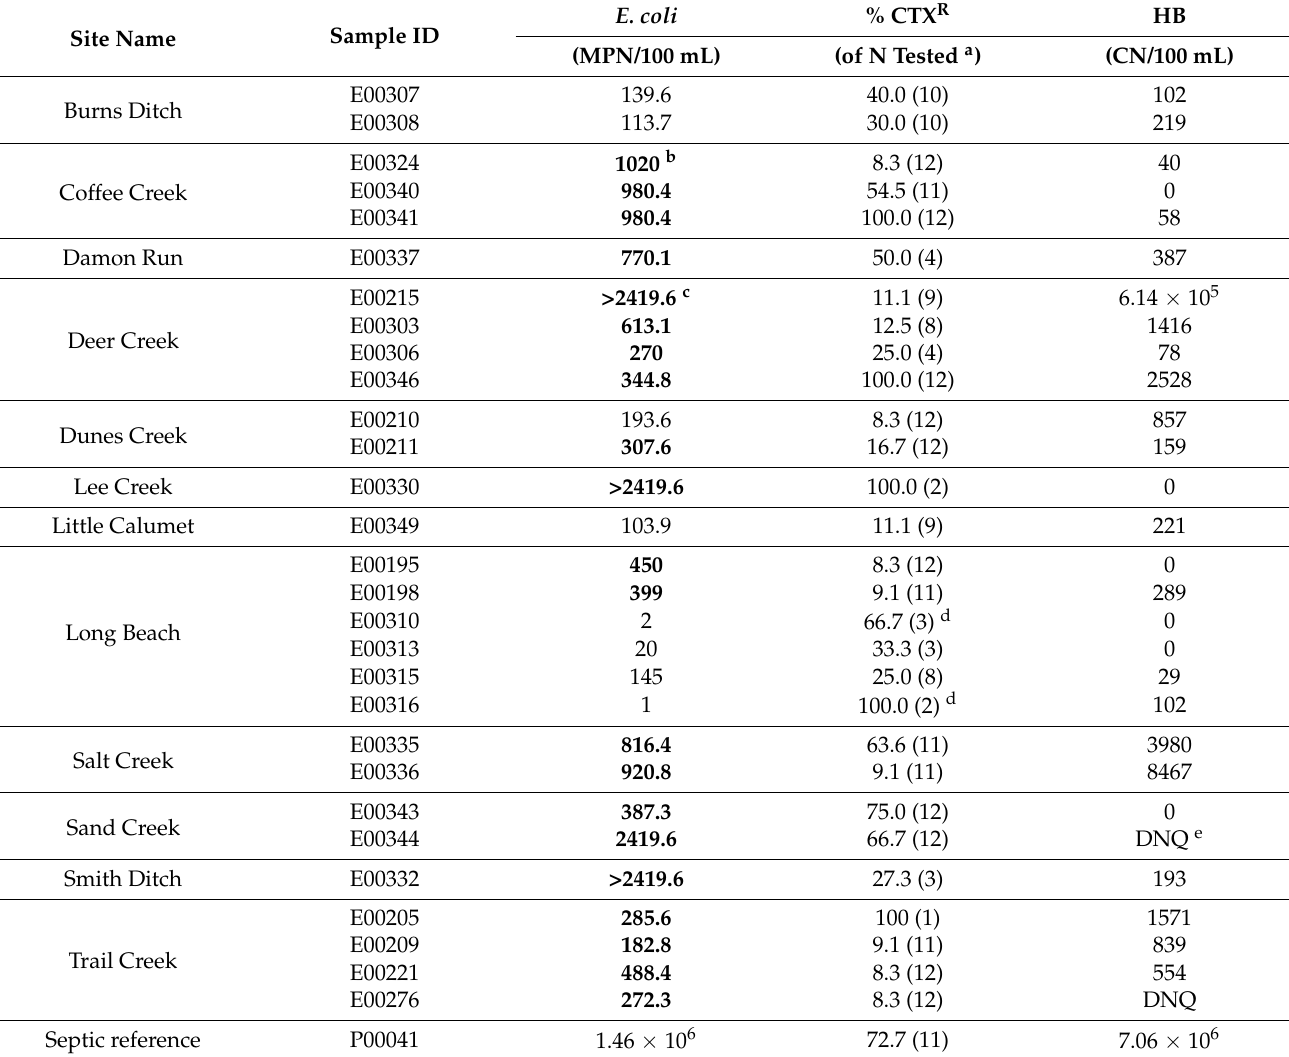
Table 1. Most probable E. coli concentrations, percent CTX-resistant E. coli , and Human Bacteroides gene copy number concentrations for sampled